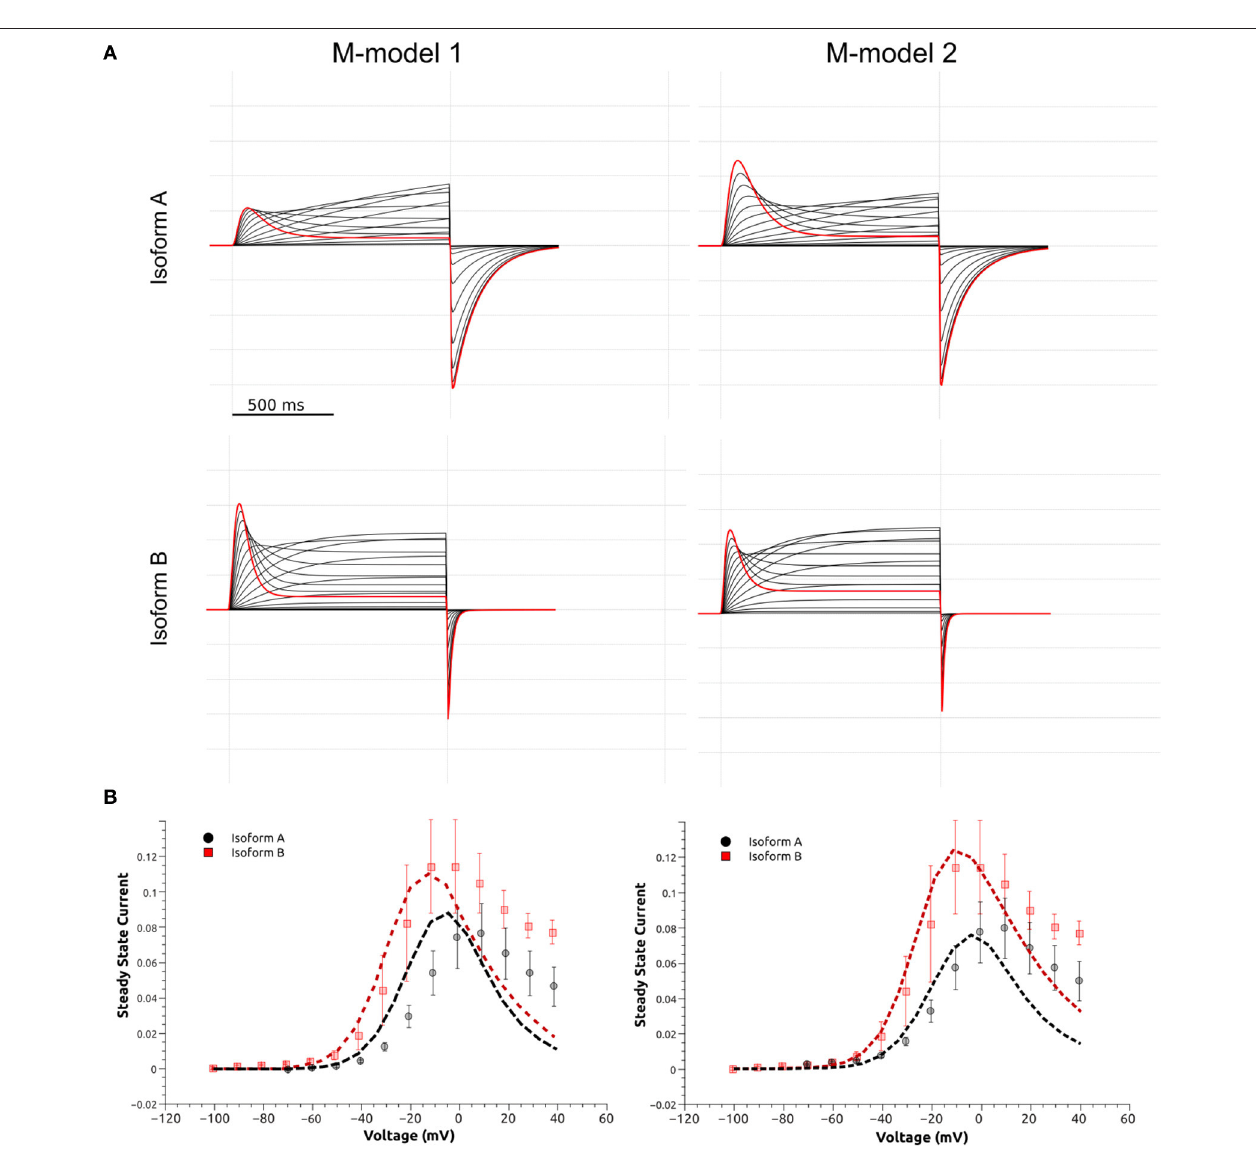
FIGURE 8 | Simulated currents M-model 1 and M-model 2. (A) Simulated currents elicited by the SSA voltage protocol (Figure 3) for both M-models and Isoforms. (B) Simulated I-V steady state current (x10 4 pA) relationship for M-model 1 and 2. a-Isoform is shown as black dashed line and b-isoform as red dashed line. Experimental data is shown in the background as symbols with the corresponding error bar (Figure 3)